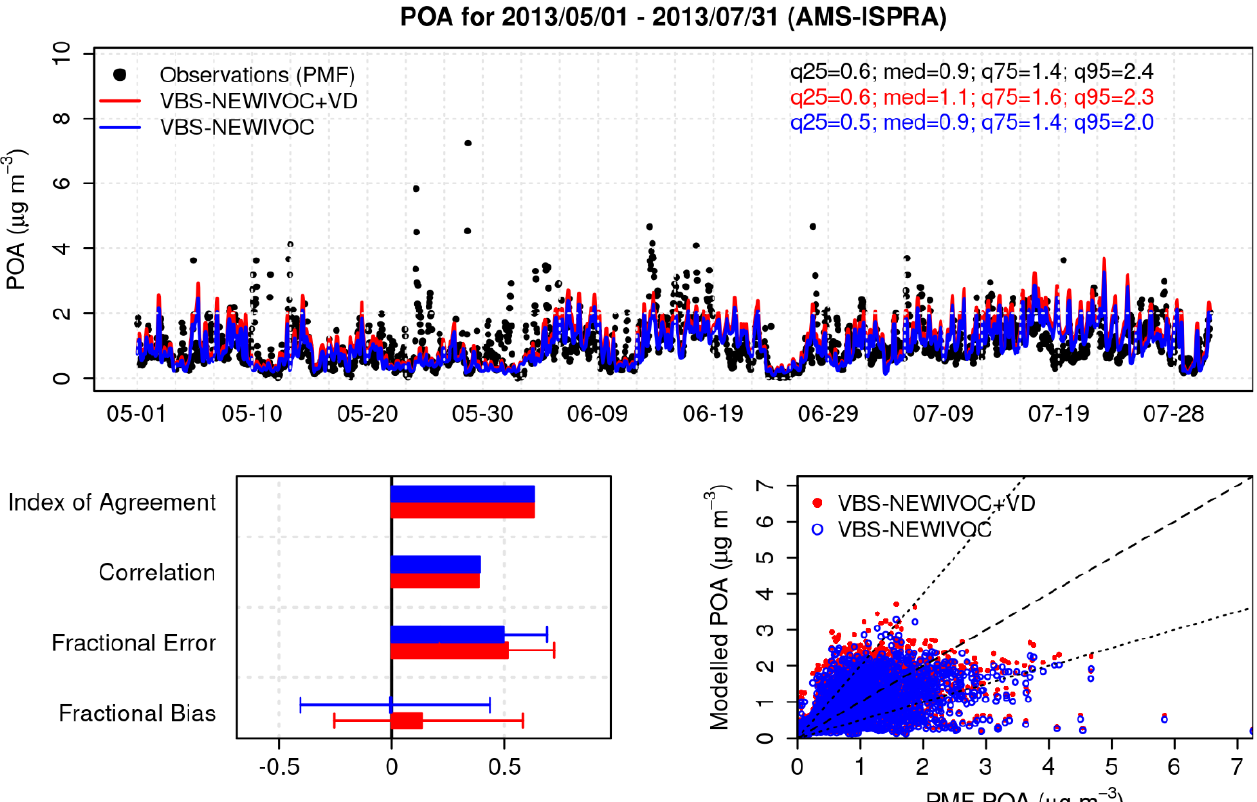
Figure 6. Comparison among modeled and observed (PMF results, black) POA concentrations during May–July 2013 at the Ispra site: VBS scheme with new parameterizations for IVOC emissions (VBS-NEWIVOC, blue) and VBS scheme with new parameterizations for IVOC emissions and revised volatility distribution (VBS-NEWIVOC+VD, red).